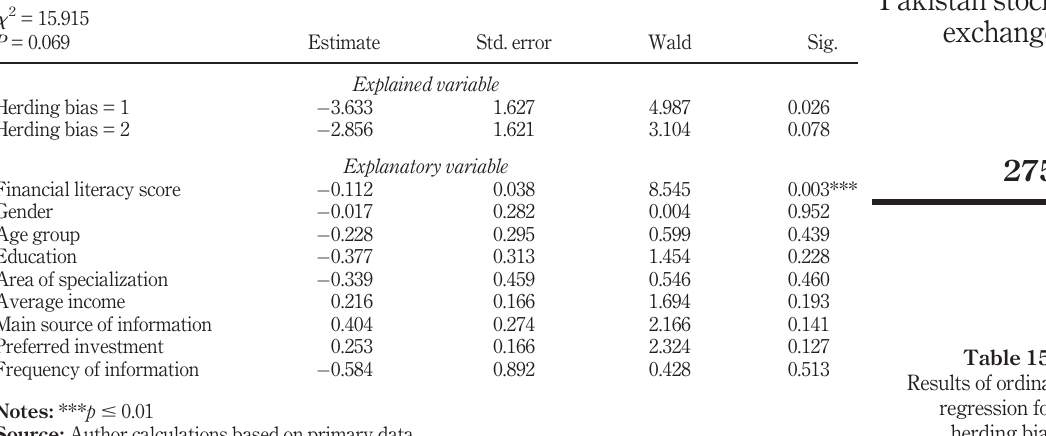
Table 15. Results of ordinal regression for herding bias